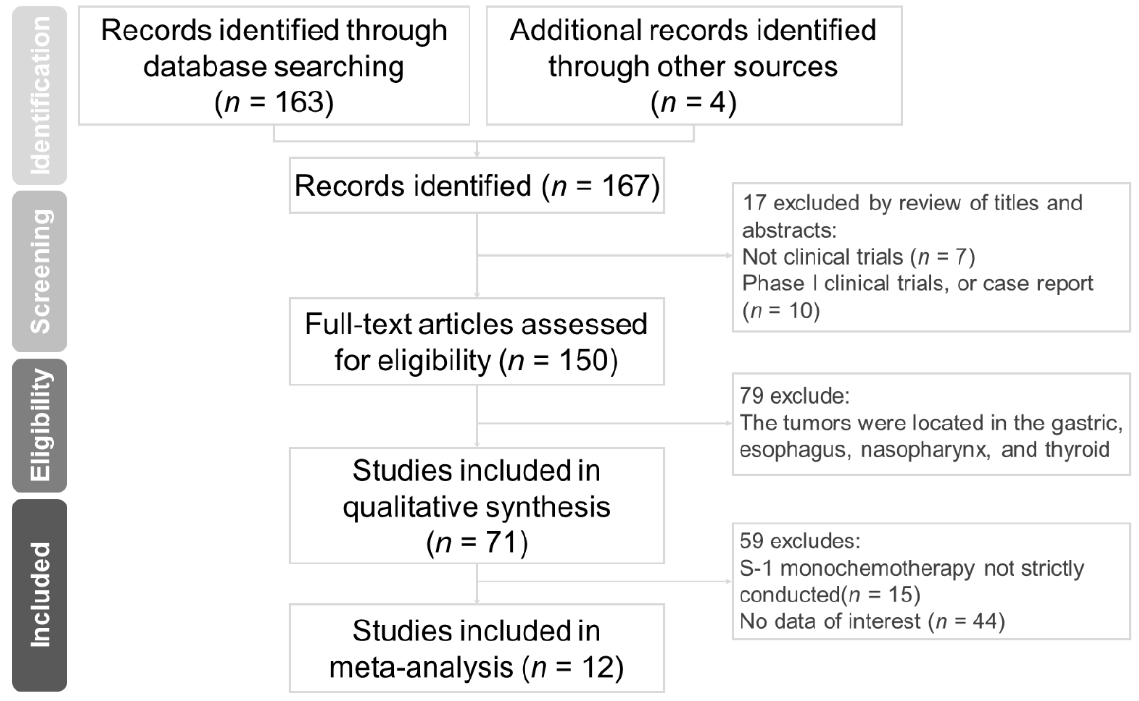
Figure 1. Flow diagram of the process used to select clinical trials.